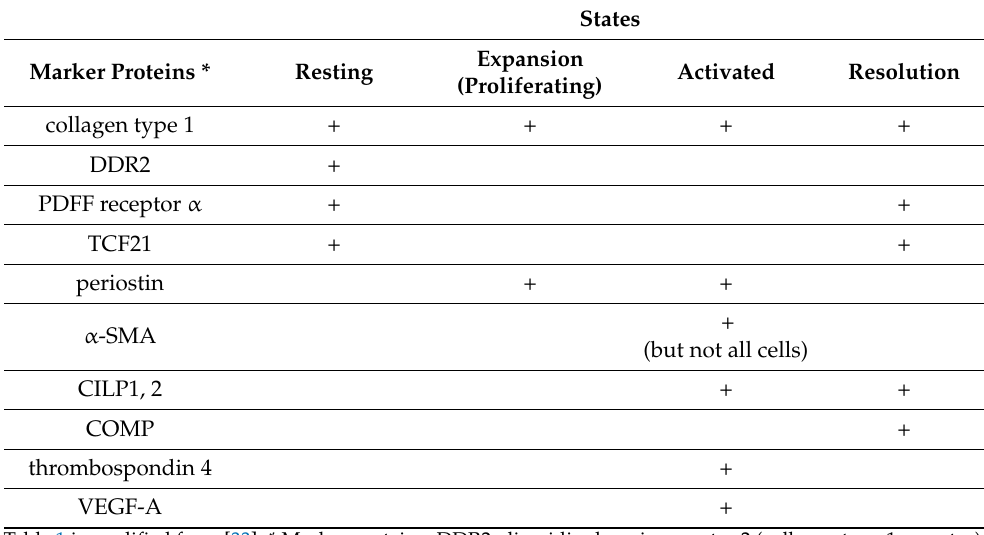
Table 1 is modified from [33]. * Marker proteins: DDR2, discoidin domain receptor 2 (collagen type 1 receptor); PDGFR- α , platelet-derived growth factor receptor- α ; TCF21, the transcription factor 21; α -SMA, α -smooth